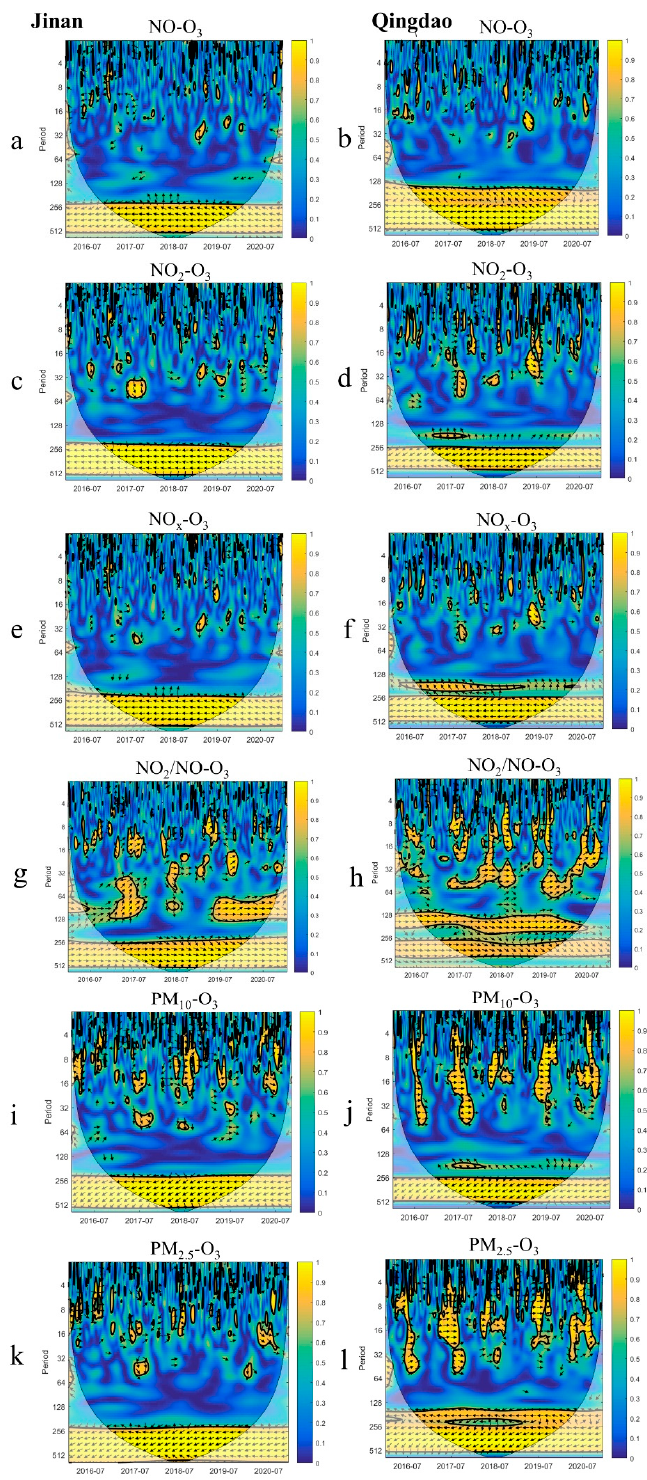
Figure 7. Wavelet coherence between O 3 and NO ( a , b ), NO 2 ( c , d ), NO x ( e , f ), NO 2 /NO ( g , h ), PM 2.5 ( i , j ), PM 10 ( k , l ). The unit of the period is days. The thick contour enclosed regions of greater than 95% confidence for a red noise process, the cone of influence where edge effects might distort the picture is shown as a lighter shade. The legend on the right shows the intensity of the wavelet power. The relative phase relationship is shown as arrows (with in-phase pointing right, anti-phase pointing left, and O 3 leading factors by 90 ◦ pointing straight down)